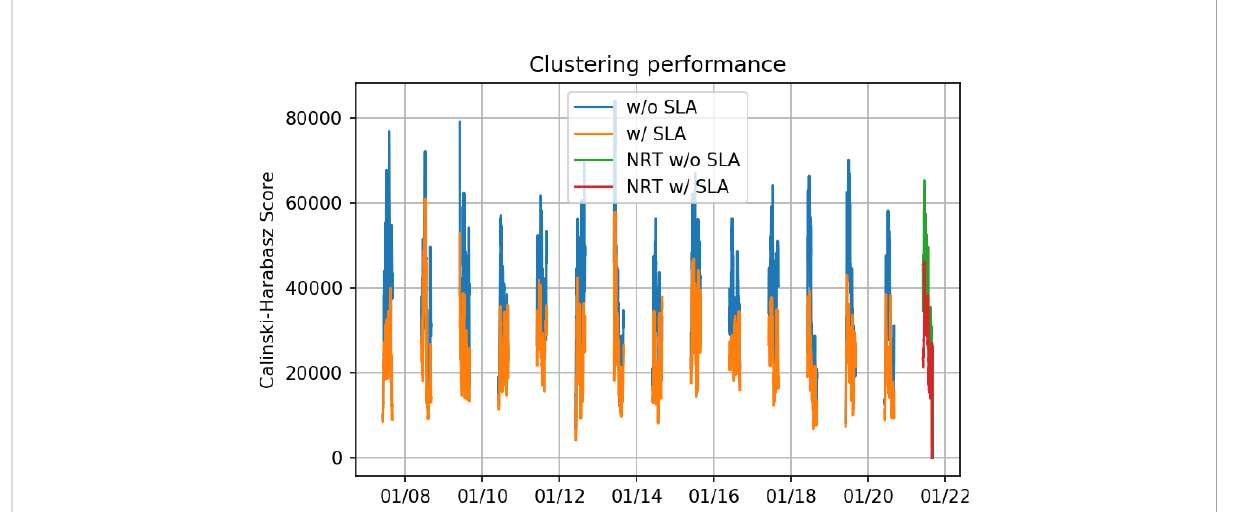
FIGURE 6 Clustering performance over the entire time series of the study, showing clustering models with and without the inclusion of SLA data, as well as the application to NRT data for both these